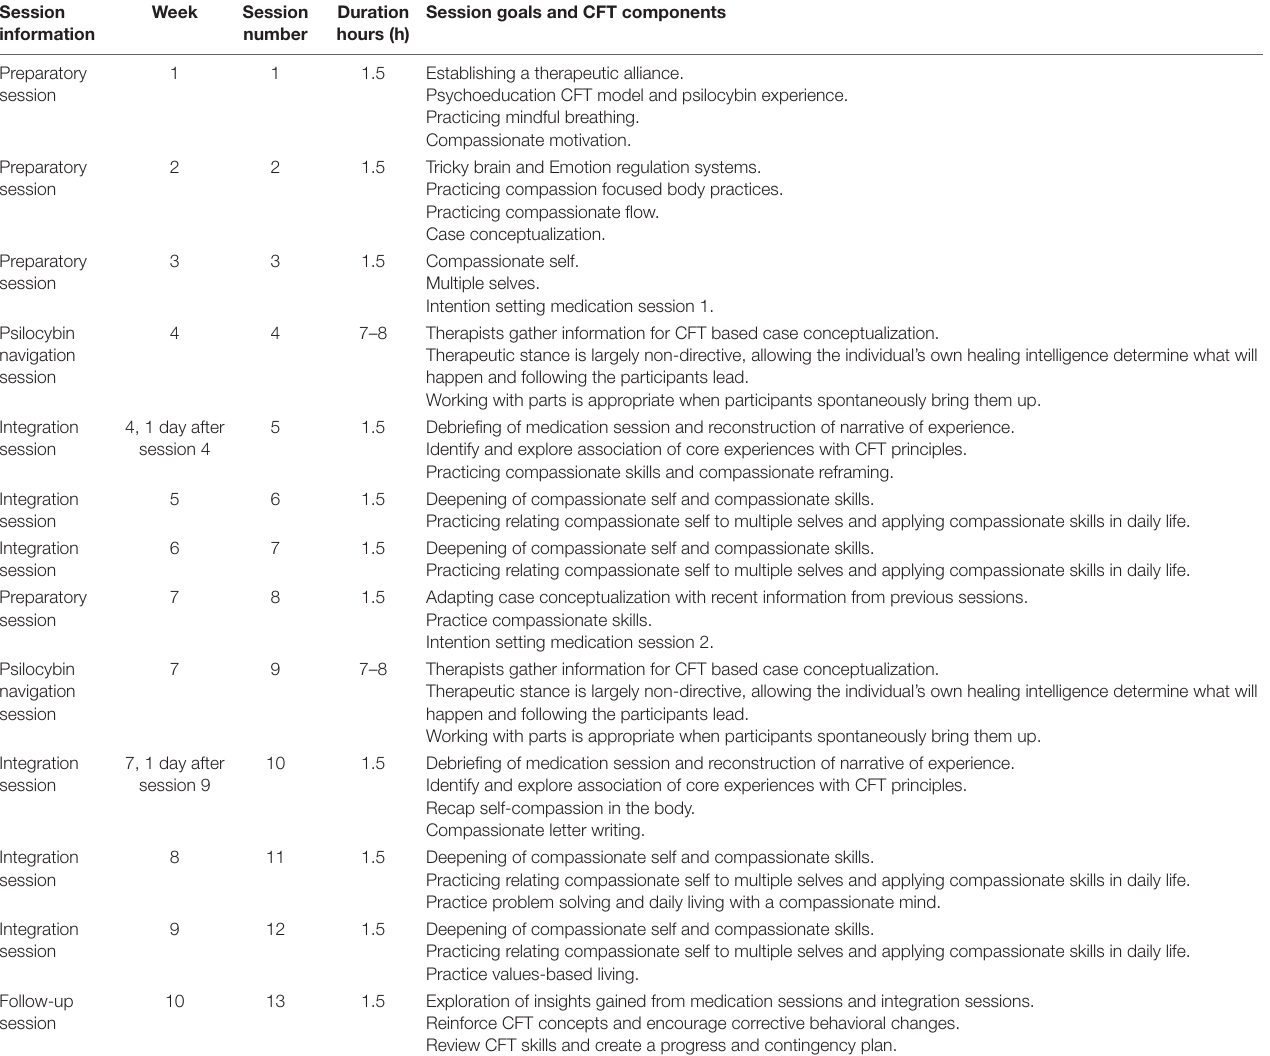
TABLE 1 | Overview of CFT-based psilocybin-assisted psychotherapy sessions in treatment protocol. Session